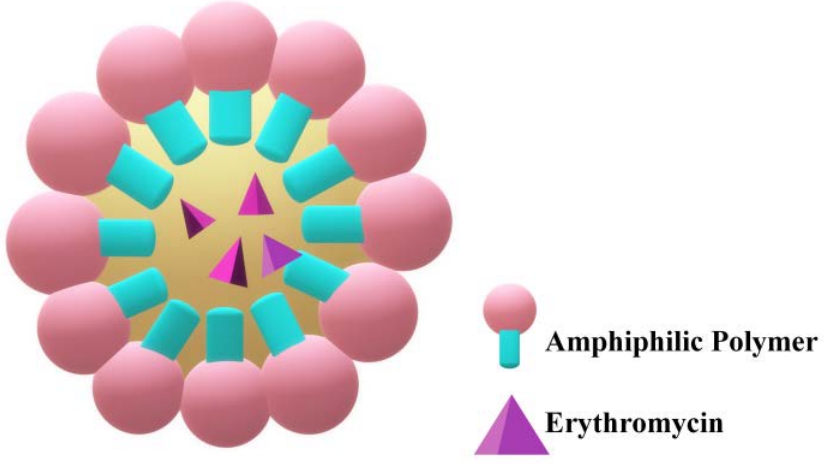
Figure 7. Schematic representation of an ERY micelle.